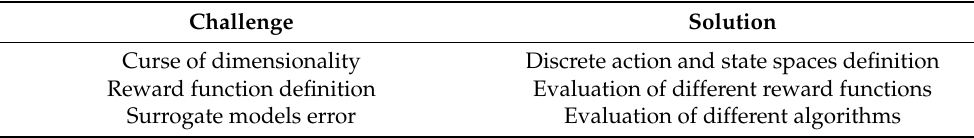
Table 9. Challenges in DP and Q-Learning